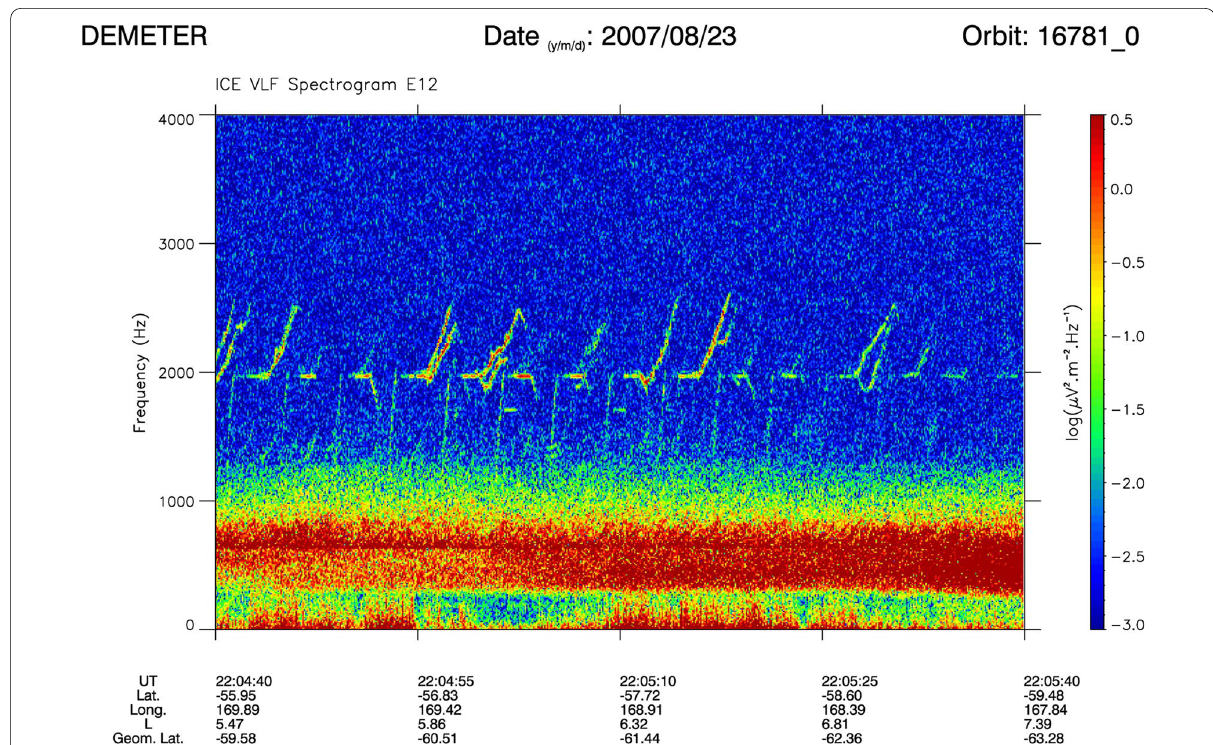
Fig. 2 Spectrogram of an electric component recorded onboard DEMETER in the Southern hemisphere between 22:04:40 and 22:05:40 UT, and in the frequency range 0–4 kHz. The power spectral density is color-coded according to the scale on the right. The parameters below the panels indicate the UT, the geographical latitude and longitude, the McIlwain parameter L , and the geomagnetic latitude